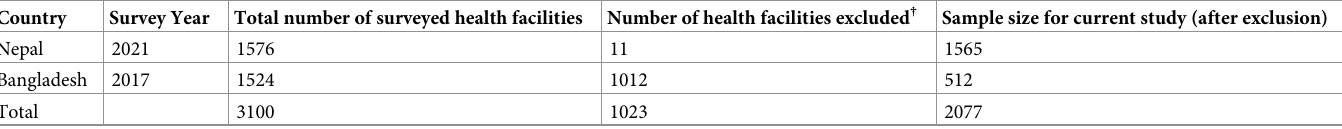
Table 1. Survey year and sample size of health facilities.